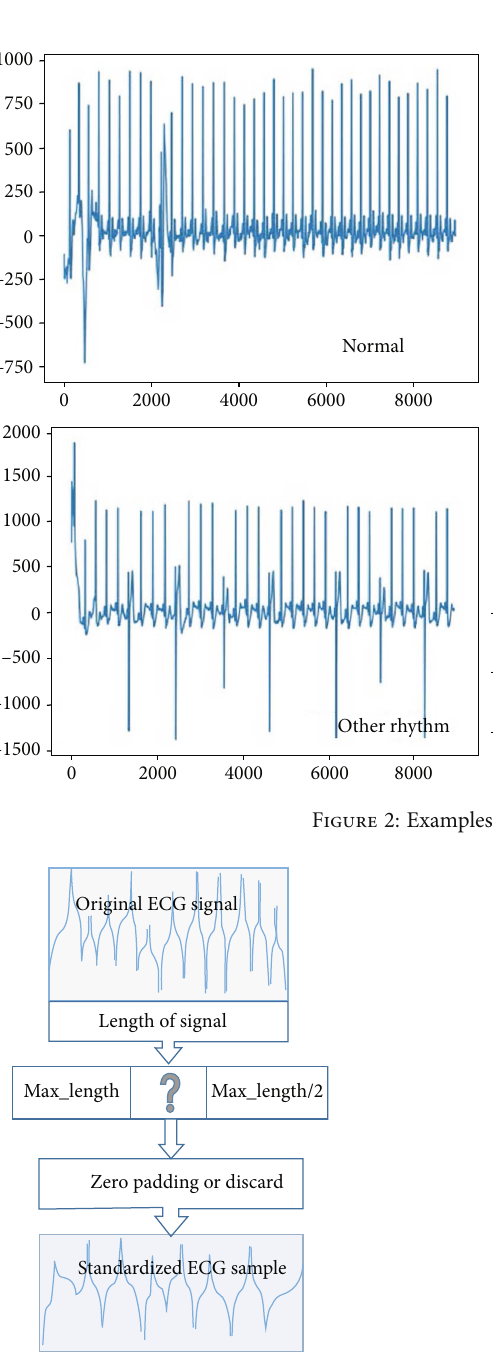
Figure 3: Normalized ECG sample generation